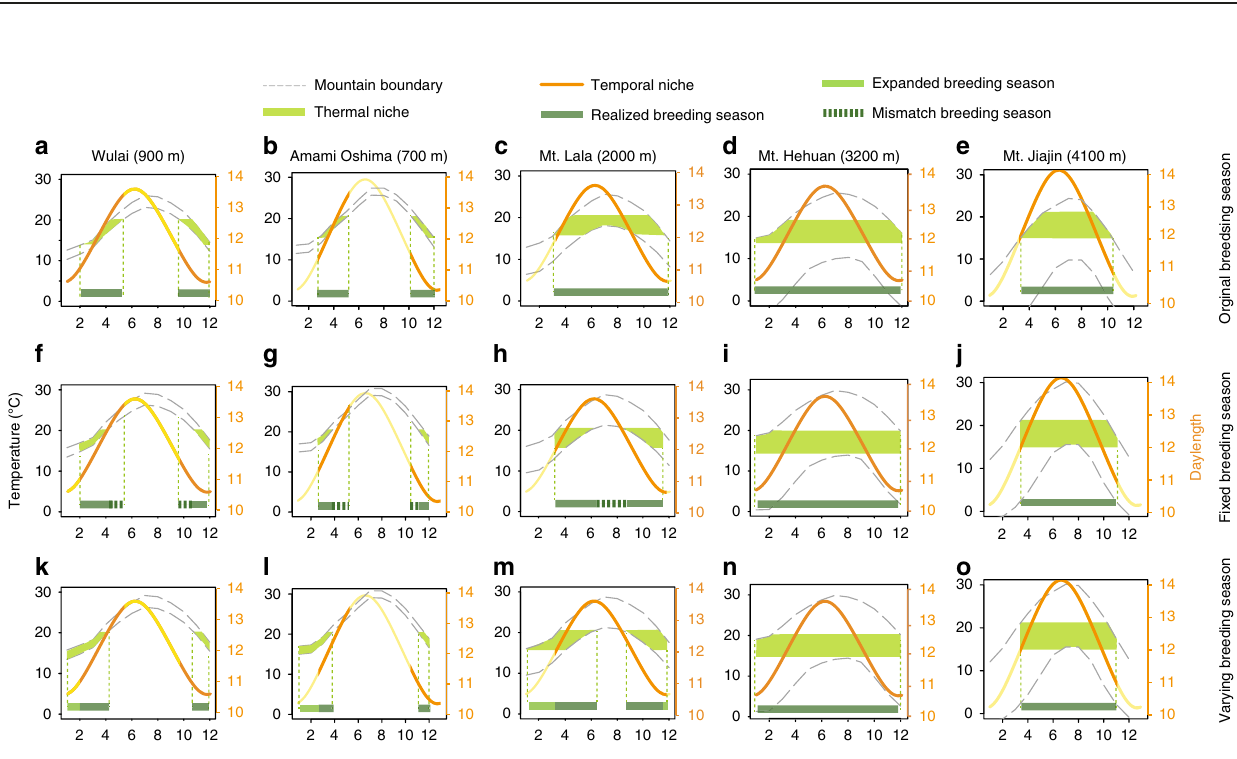
Fig. 6 Results of reciprocal transplant experiment between the low elevation Wulai and high elevation Mt. Hehuan populations in winter and summer. Breeding likelihood and breeding success of the Mt. Hehuan and Wulai populations in summer in Wulai a , b (burial rate: χ ² 1 = 4.60, p = 0.03, n = 120, breeding success: χ ² 1 = 1.13, p = 0.29, n = 120; post hoc comparison: burial rate: z = 2.202, P = 0.028, breeding success: z = − 0.955, P = 0.34), and Mt. Hehuan c , d (burial rate: χ ² 1 = 12.96, p < 0.001, n = 93; breeding success: χ ² 1 = 8.60, p = 0.003, n = 93; post hoc comparison: burial rate: z = 4.185, P < 0.0001, breeding success: z = 3.012, P = 0.026), and in winter in Wulai e , f (burial rate: χ ² 1 = 0.26, p = 0.61, n = 78; breeding success: χ ² 1 = 1.90, p = 0.17, n = 78), and Mt. Hehuan g , h (burial rate: χ ² = 2.45, p = 0.12, n = 83; breeding success: χ ² = 3.88, p = 0.05, n = 83; post hoc comparison: burial rate: z = 1 1 − 1.969, P = 0.049). All the analyses were conducted by GLMM, and the p values were obtained from the two-sided tests. The standard error was presented as the error bar; p < 0.1; * p < 0.05; ** p < 0.01; *** p < 0.001.